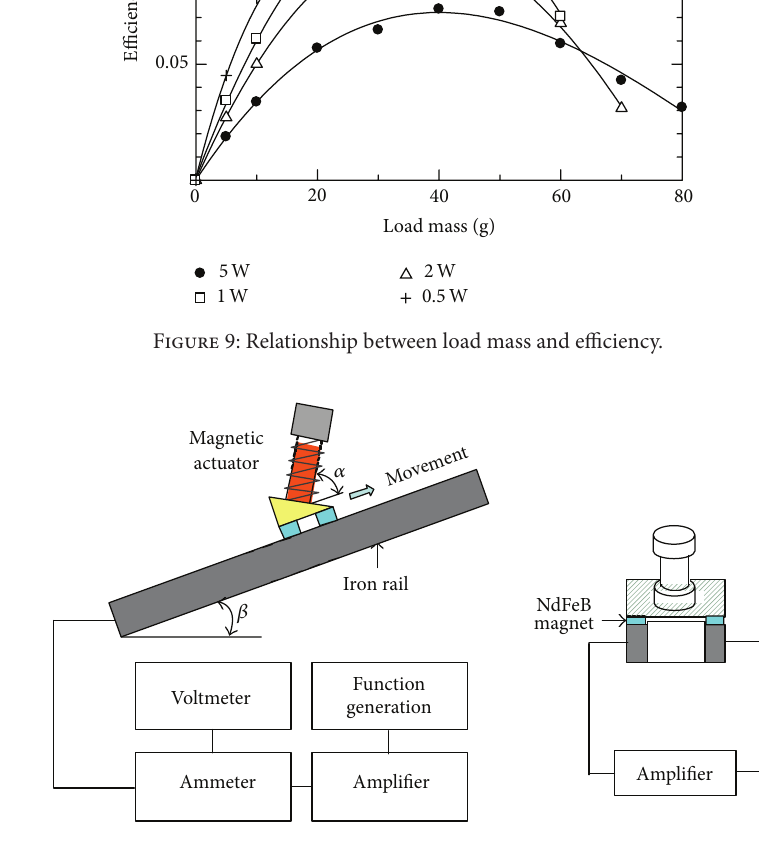
Figure 10: Experimental apparatus for cable-free model.